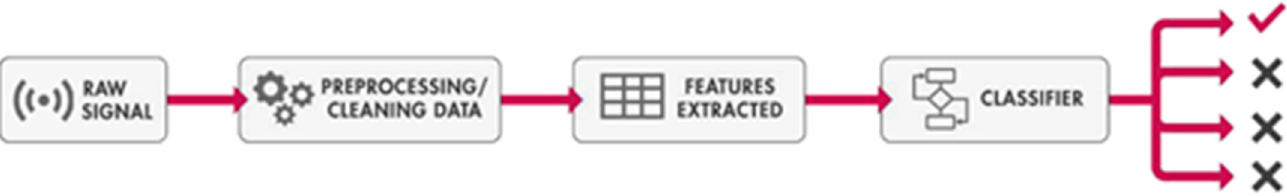
Figure 5. Schematic outline of the proposed feature extraction.